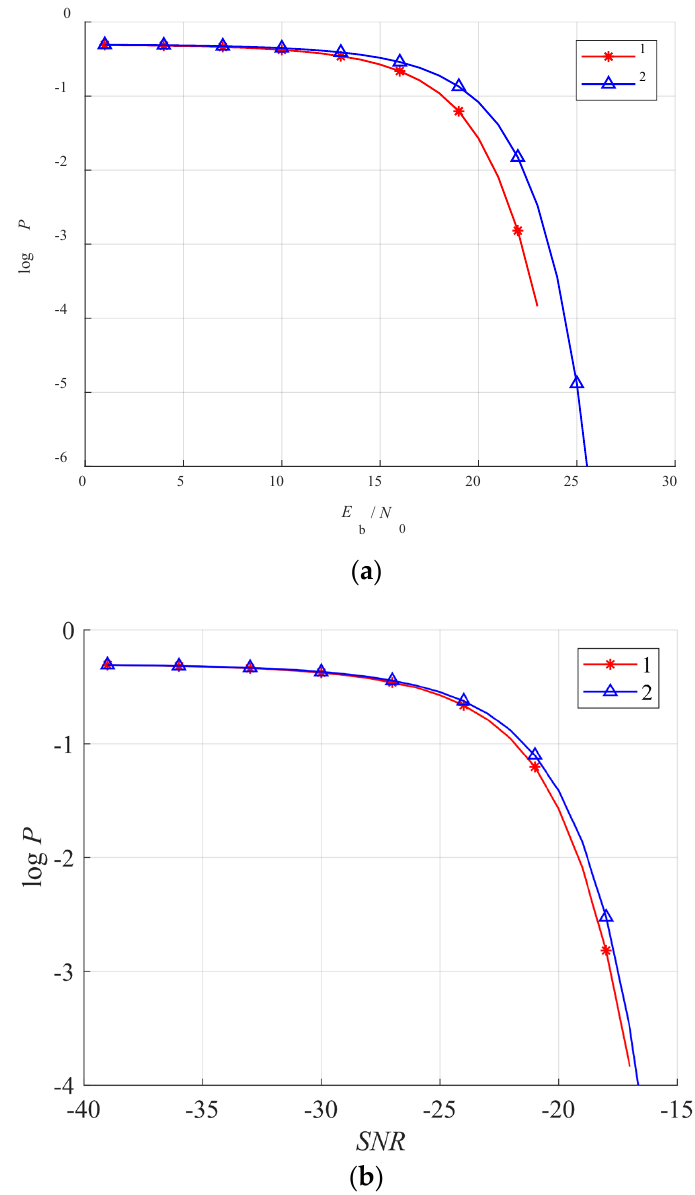
Figure 11. Bit error probability as a function of: ( a ) E b / N 0 at K = 10,000; ( b ) SNR. Curve 1—simulation for a Gaussian distribution, 2—analytical estimate.